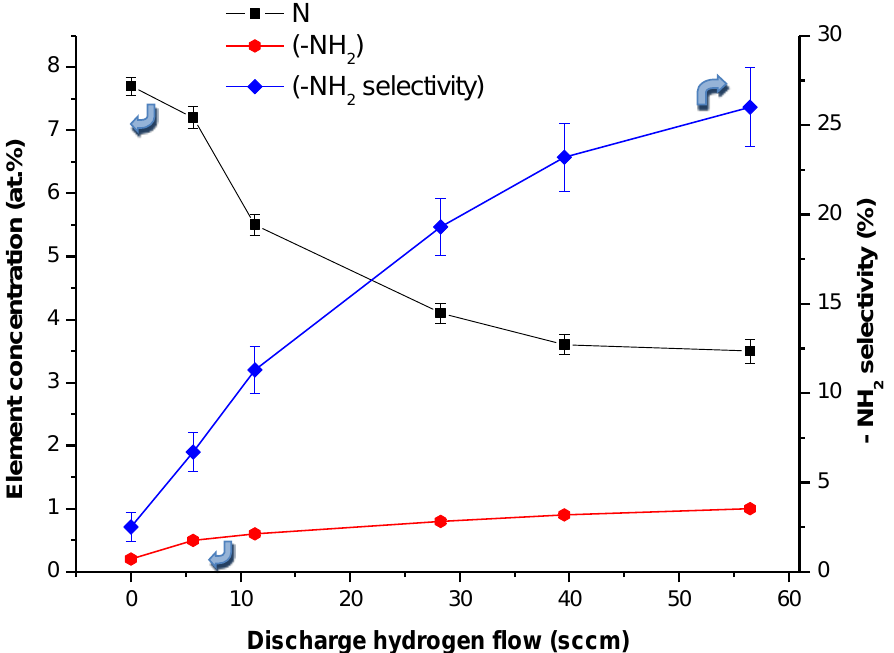
Figure 3. Quantity and selectivity of primary amines and nitrogen content in function of H flow directly introduced in the discharge chamber. 2